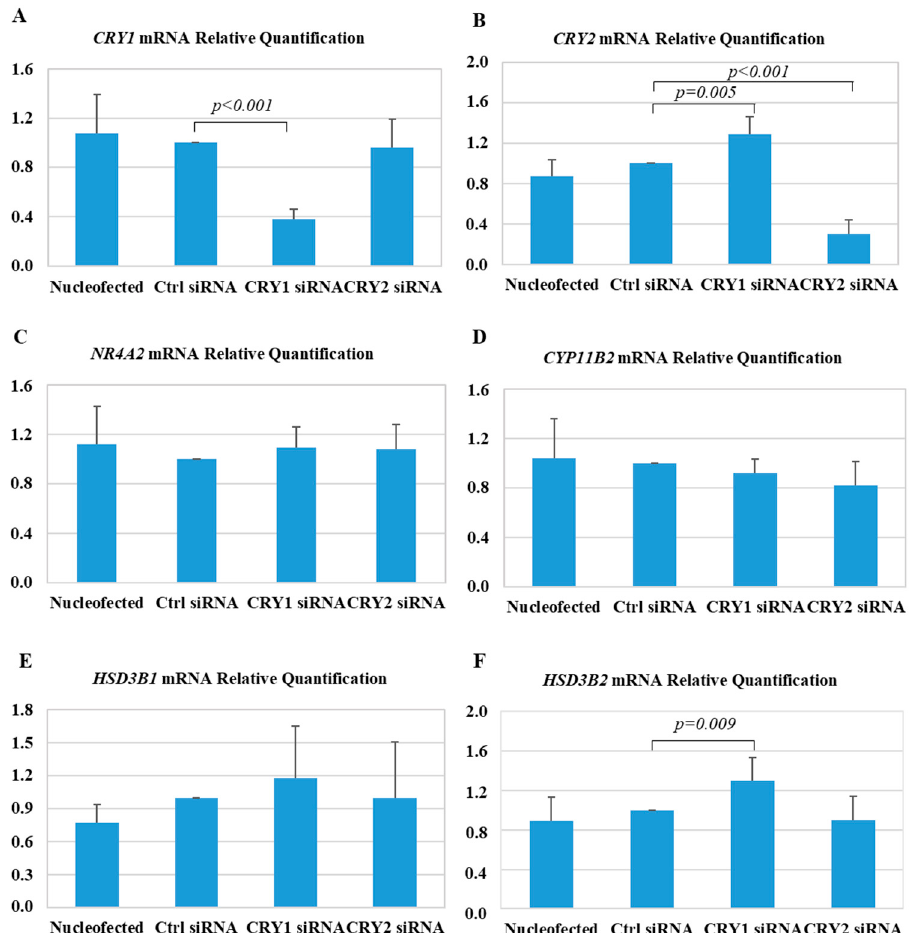
Figure 5. Effect of silencing CRY1 and CRY2 on gene expression in HAC15 adrenocortical cells. Real-time PCR analysis of CRY1 ( A ), CRY2 ( B ), HSD3B1 ( C ), HSD3B2 ( D ), NR4A2 ( E ), and CYP11B2 ( F ) gene expression. Each bar expresses the mean ± SD fold change over the expression in cells transfected with a control small interfering RNA (siRNA; Ctrl siRNA) of at least five independent experiments. No significant differences were detected between the cells transfected with Ctrl siRNA, and electroporated cells (Nucleofected).